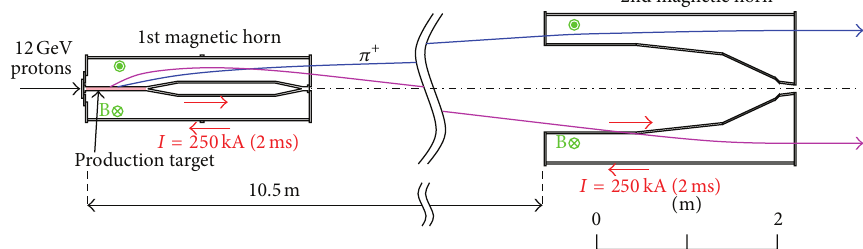
Figure 2: A schematic showing the layout and operation of the K2K beamline target and